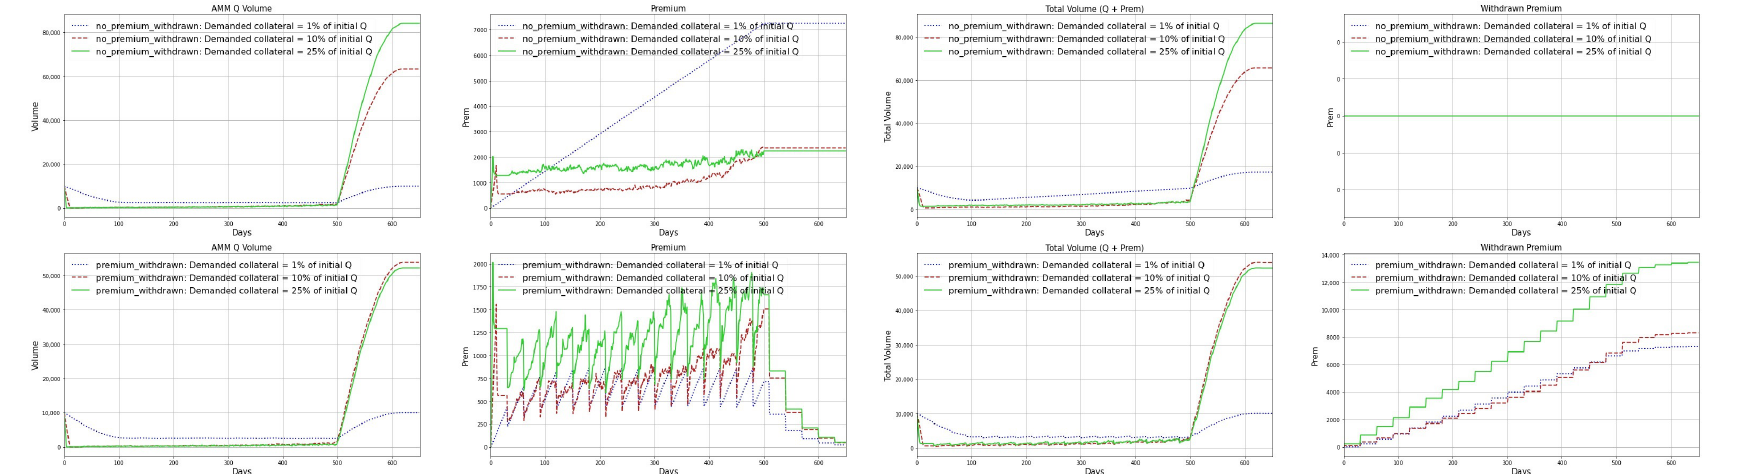
Figure A11. rkAMM Curves from simulation of scenario 4 and 30 days of withdrawal period.